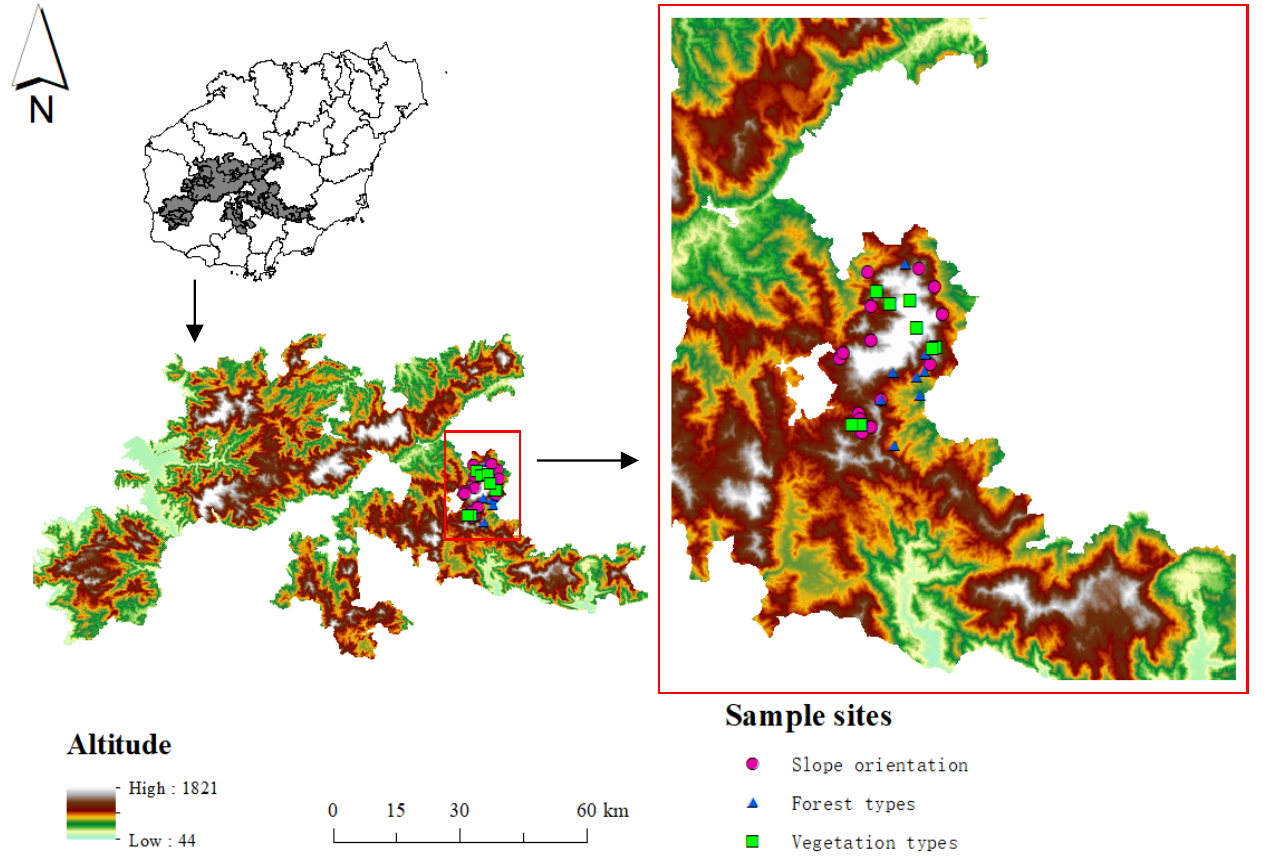
Figure 1. Map of the sampling sites in the Wuzhishan National Nature Reserve. All sampling sites are shown in red boxes. Purple circles represent the eight slope orientation samples, blue triangles represent the three forest type samples and green squares represent the four vegetation type samples. The distance between any two samples is >10 m meters.